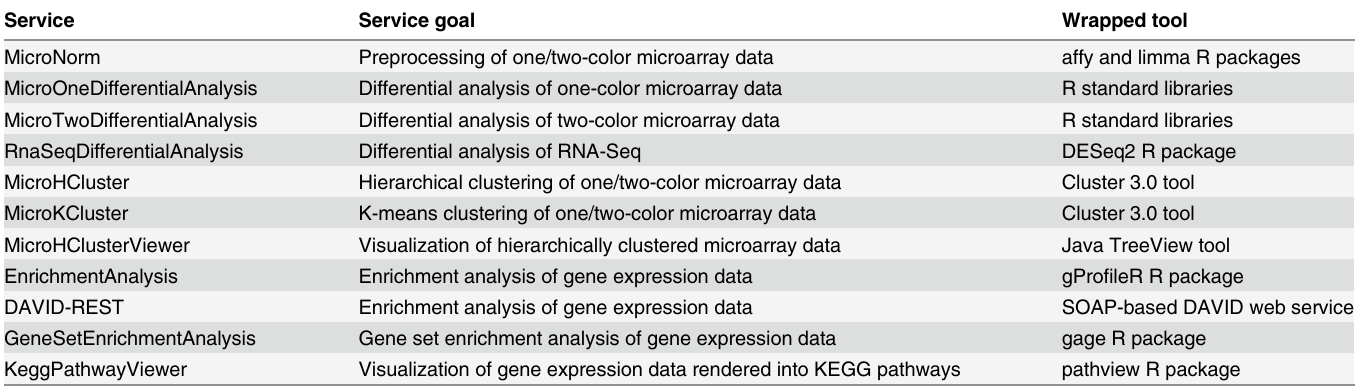
Table 1. RESTful semantic web services available in the GEAS